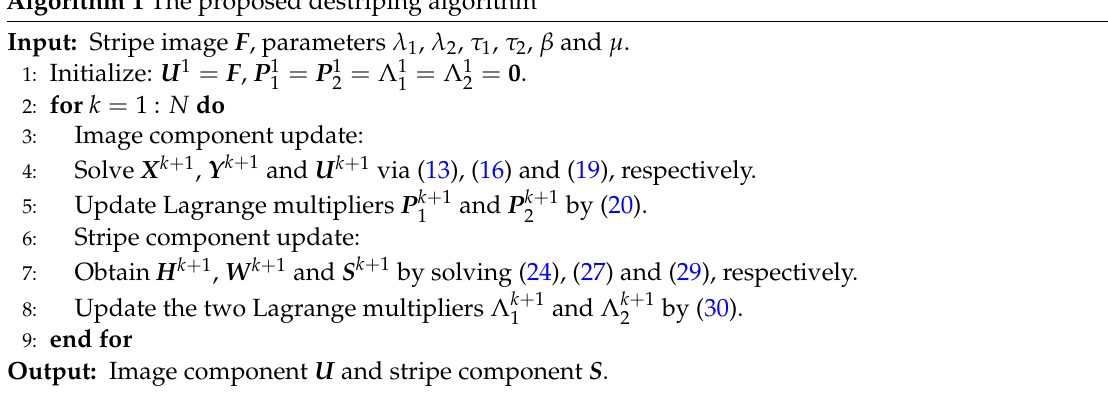
Algorithm 1 The proposed destriping